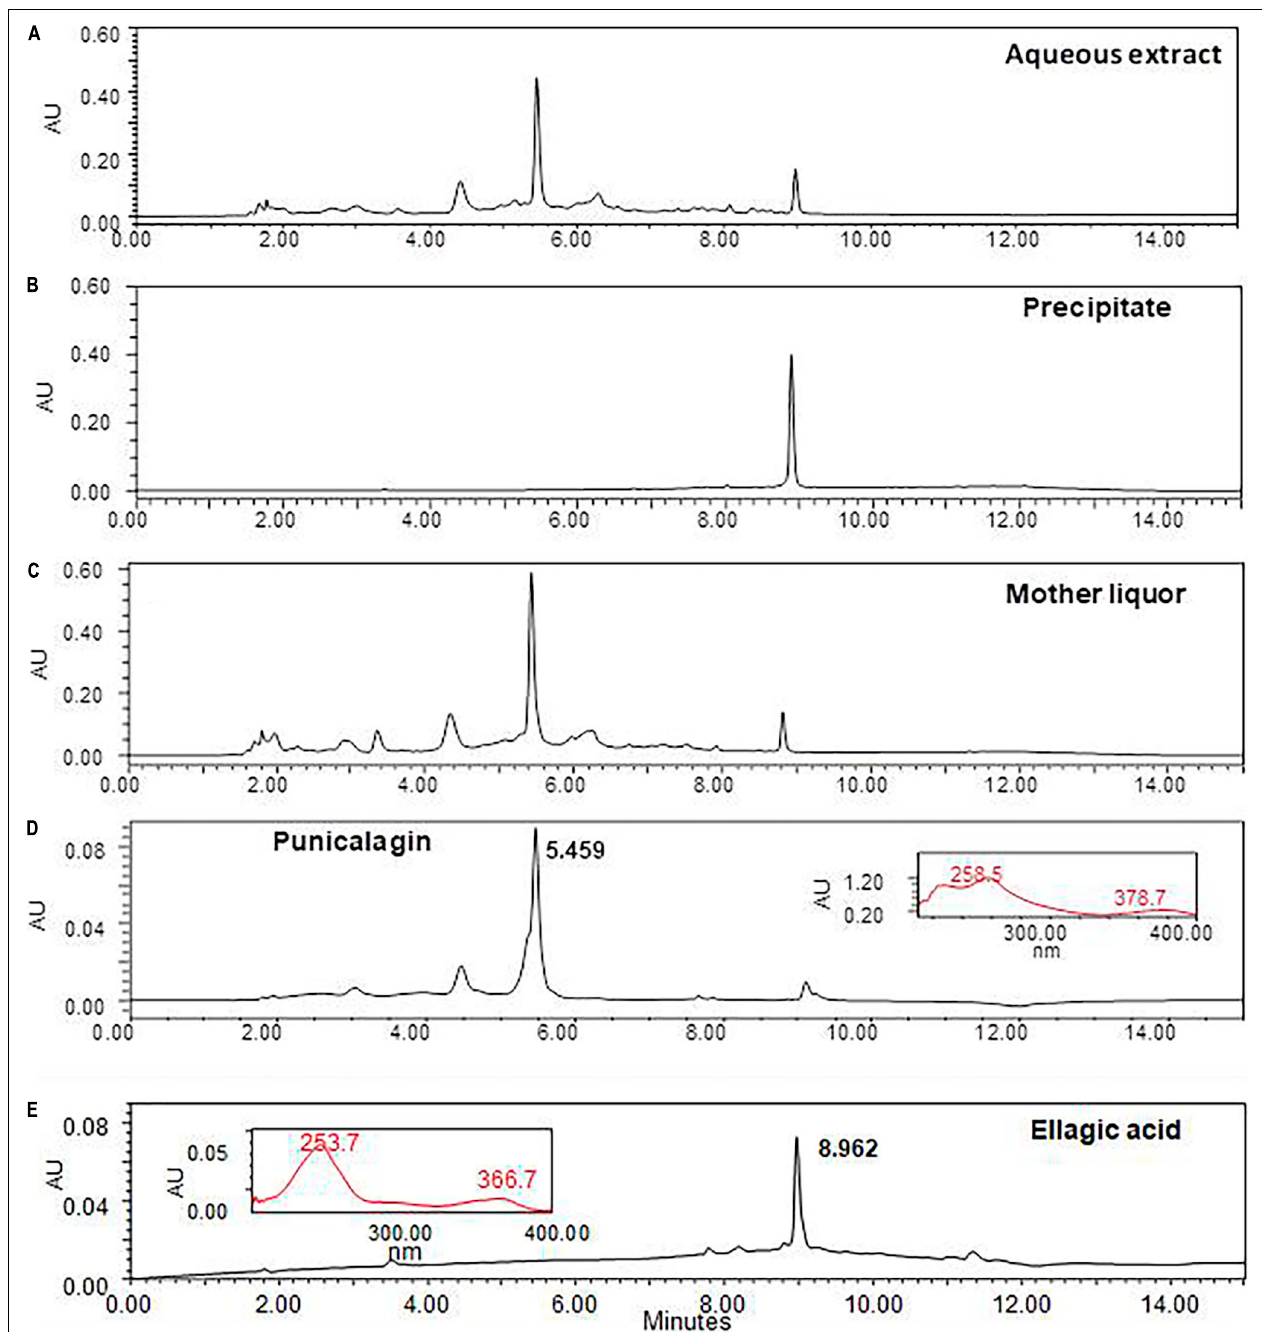
FIGURE 7 | Chromatographic profile of the Punica granatum aqueous extract (AEPG) and fractions. The AEPG fruit [panel (A) , 10 mg/mL] and its fractions from precipitated solids [panel (B) , 2 mg/mL] and liophylized of mother liquor [panel (C) , 2 mg/mL] were analyzed by UPLC technique to determine the presence of punicalagin [panel (D) , retention time 5.459 min], and ellagic acid [panel (E) , retention time 8.962 min] as two of the most abundant